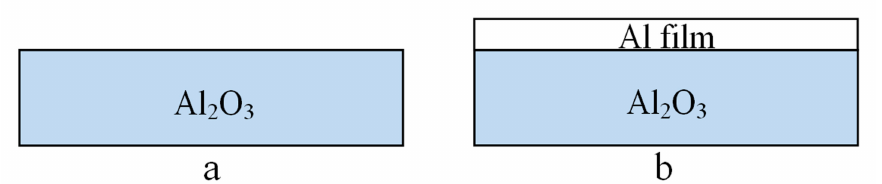
Figure 1. The schematic of two kinds of Al 2 O 3 ceramic samples. ( a ) without Al film deposited; ( b ) with Al film